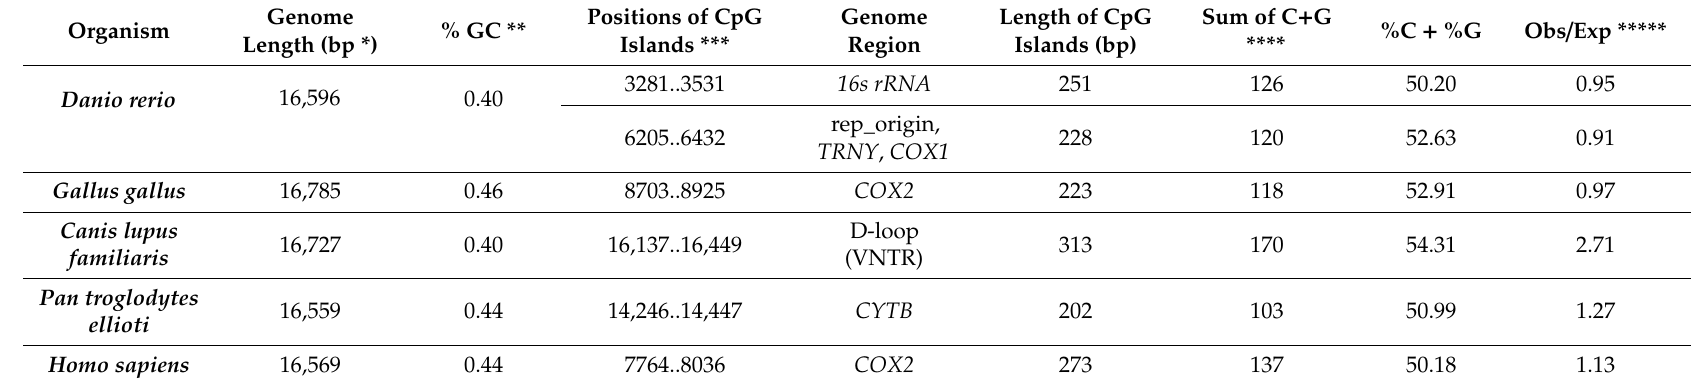
Table 2. Positions of CpG islands in the mitochondrial genomes of the analysed animals on the light